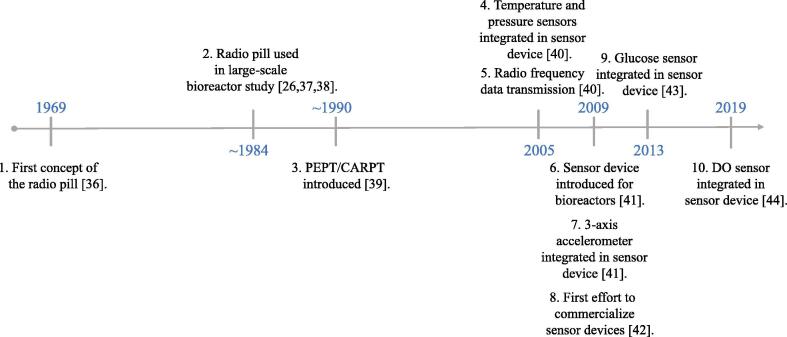
Timeline highlighting important developments in Lagrangian technologies for bioreactors. (See above-mentioned reference for further information.)